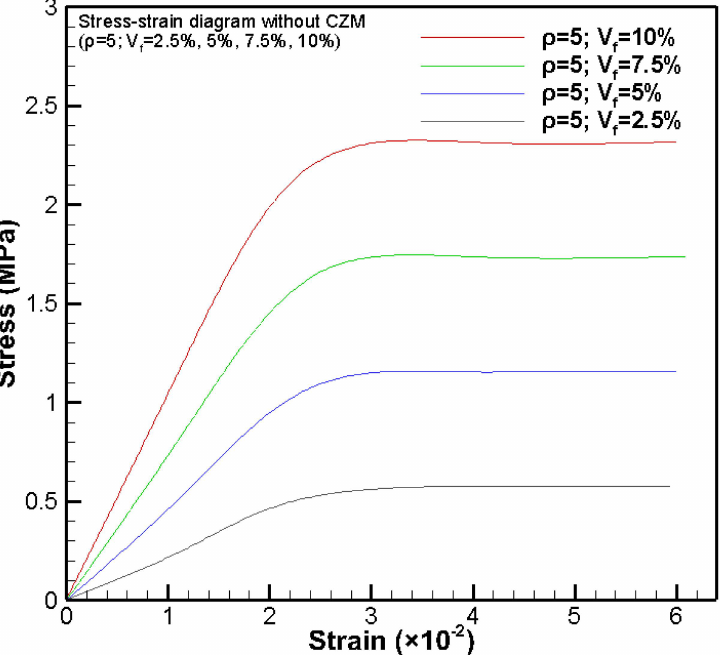
Figure 22. Effective stress-strain diagrams of the PNC (reinforced with edge-curved clay nanoparti- cles) without CZM at the nanoparticle volume fraction of V f = 2.5%, 5%, 7.5%, and 10%, respectively ( ρ =